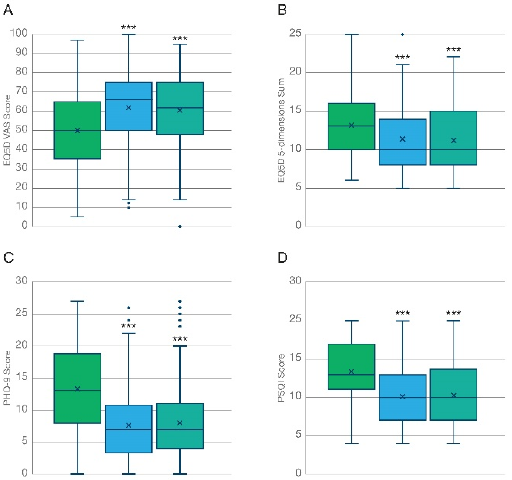
Figure 3. Comparative improvement of general health outcome measures at 3- and 6-month follow- up. Analysis of outcome measures reported by patients that completed the validated questionnaires both at 3- and at 6-month follow-up visits (N = 140). Improvements associated with the inhalation of KHIRON 20/1 in ( A , B ) HRQoL, ( C ) General mood/ clinical depression, and ( D ) quality of sleep were maximal at 3 months and maintained, although not further increased, at the 6-month follow-up. *** p <